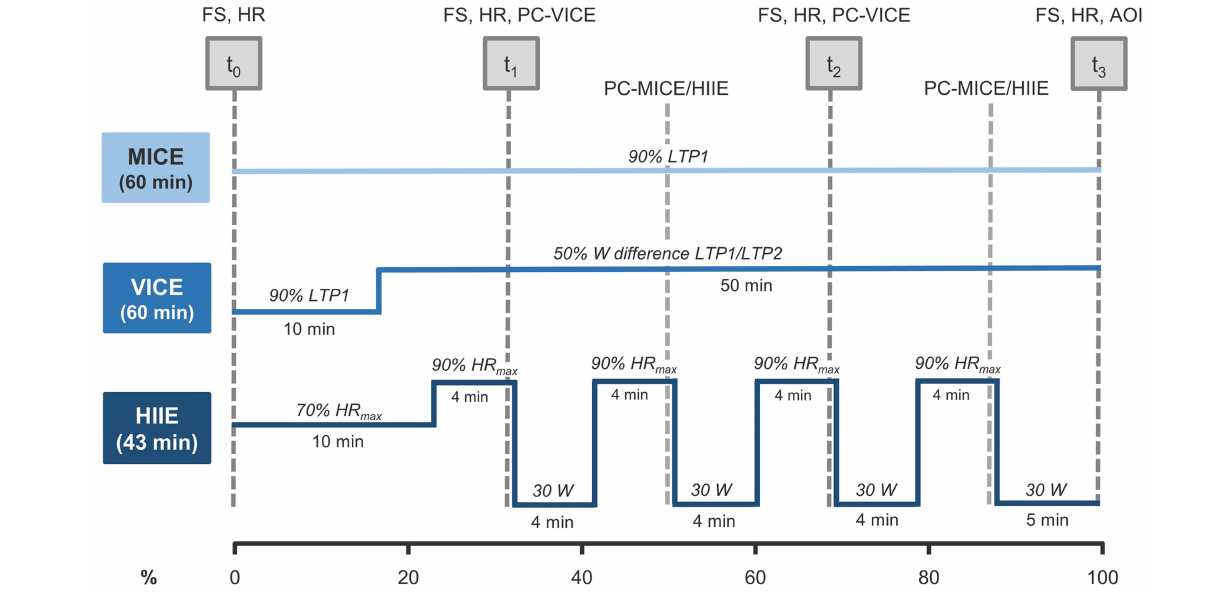
FIGURE 2 | Overview of exercise modalities and measures. Data was collected at 4 points in time: pre-exercise (t 0 ), in-task (t 1 , t 2 ), and post-exercise (t 3 ). The x-axis describes the percentage of exercise completed (0–100%). FS, Feeling Scale; HR, heart rate; PC-VICE, perceived competence assessed in VICE; PC-MICE/HIIE, perceived competence assessed in MICE/HIIE; AOI, awareness of interoceptive cues; MICE, moderate-intensity continuous exercise; VICE, vigorous-intensity continuous exercise; HIIE, high-intensity interval exercise; LTP1, first lactate turning point; LTP2, second lactate turning